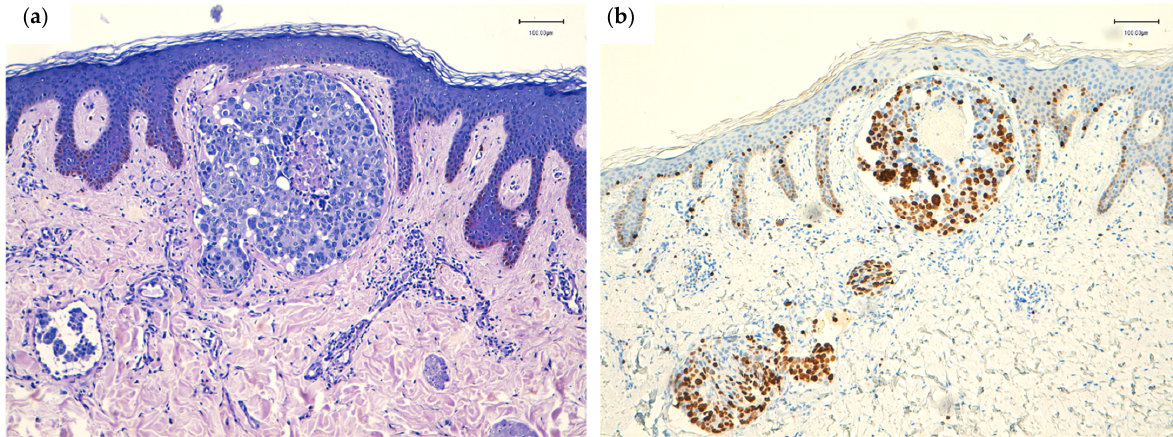
Figure 2. (a) Lymphovascular permeation in dermal lymphatics. H&E; original magnification, 100 ×. (b) High proliferation index in tumor emboli (Ki-67; Clon Mib-1, Agilent). Original magnification, 100×.